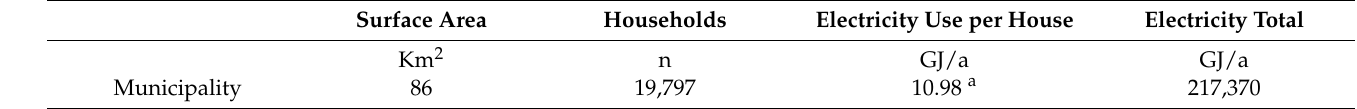
Table A3. The main properties of the average municipality.